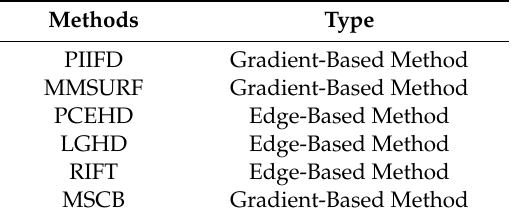
Table 4. Multi-modality image matching methods.